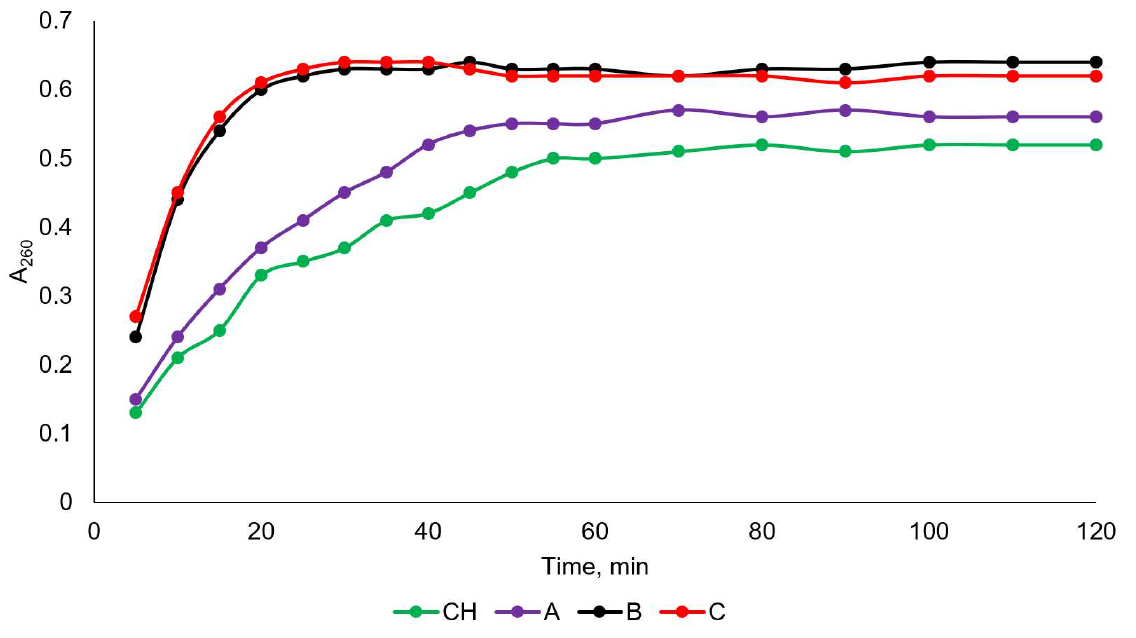
Figure 6. The effects of chitosan (CH), POX-1 (A), POX-2 (B), POX-3 (C) on the integrity of the cell membranes of E. coli .